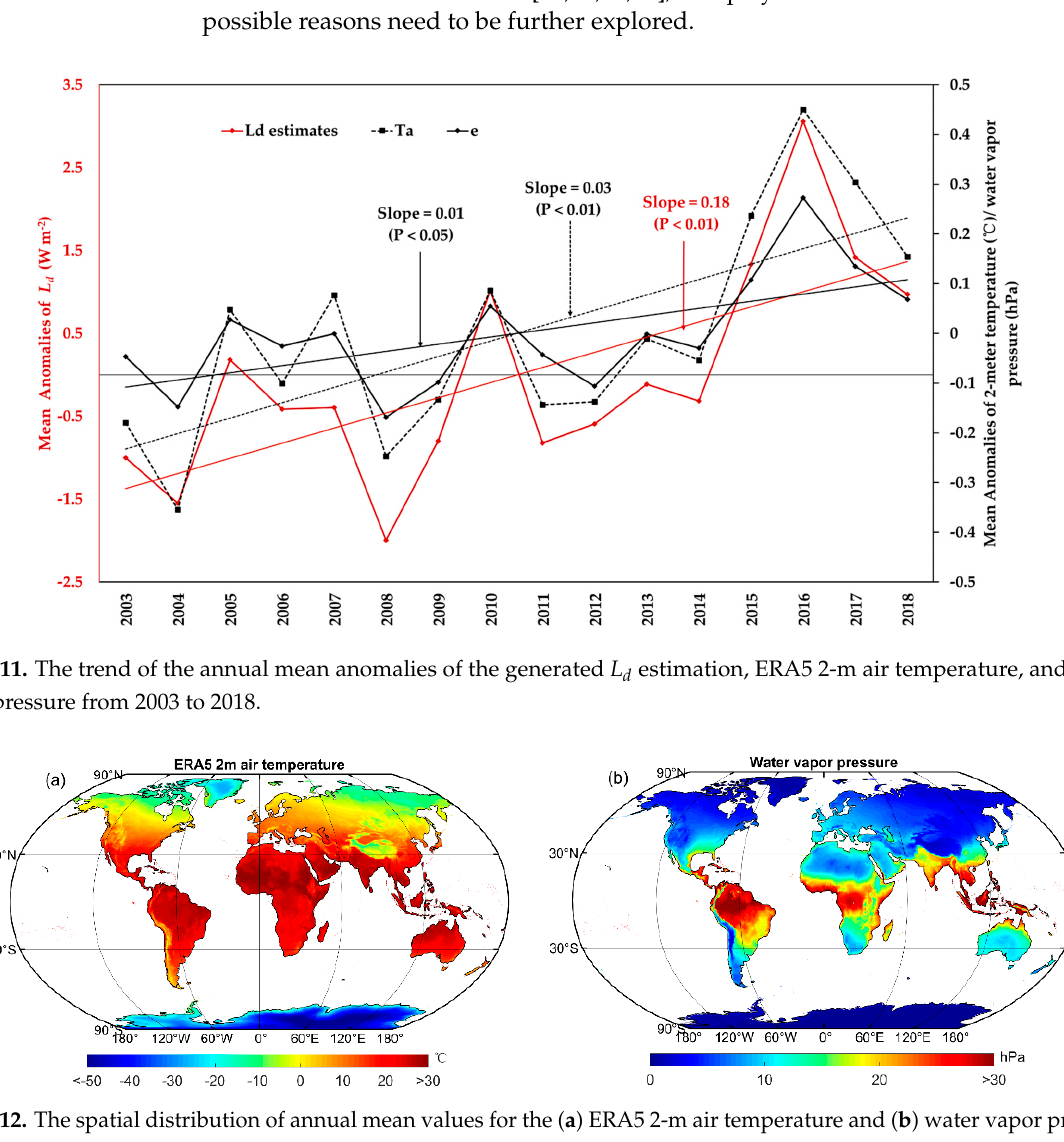
Figure 12. The spatial distribution of annual mean values for the ( a ) ERA5 2-m air temperature and ( b ) water vapor pressure from 2003 to 2018.